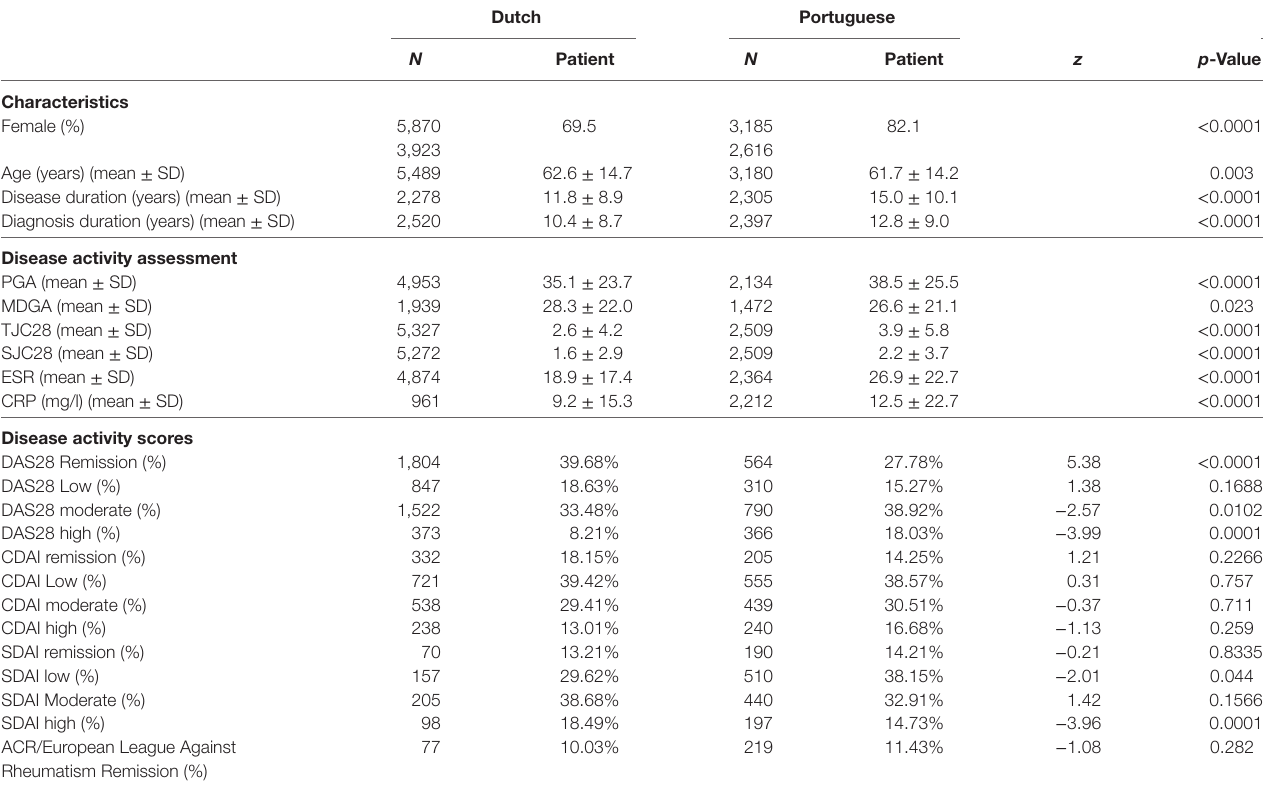
TaBle 6 | Patients’ characteristics and disease activity assessment using a randomly selected visit per